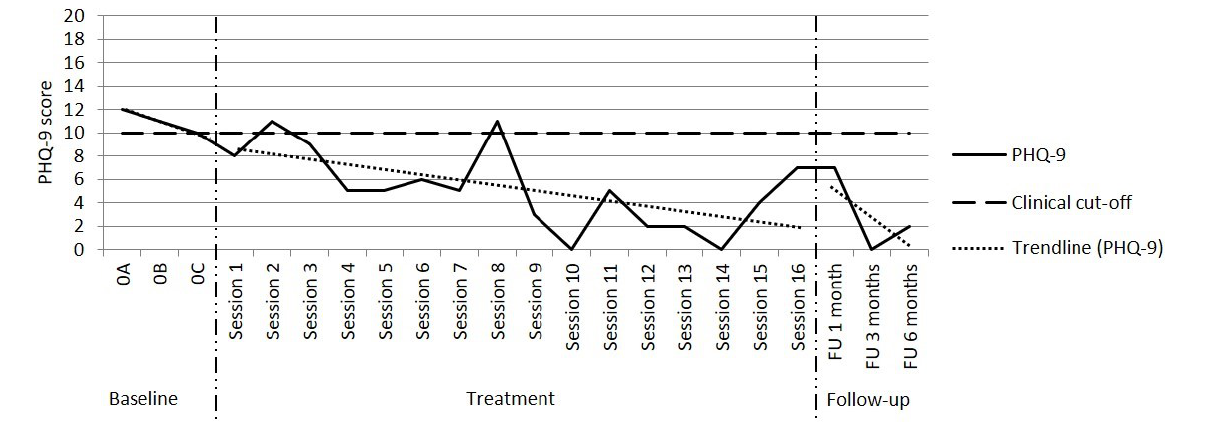
Figure 1: Beatrice’s weekly depressive (PHQ -9)